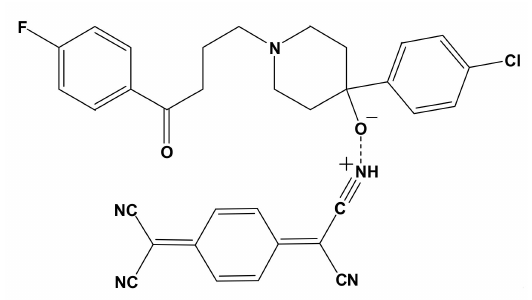
Figure 2. CT complex of